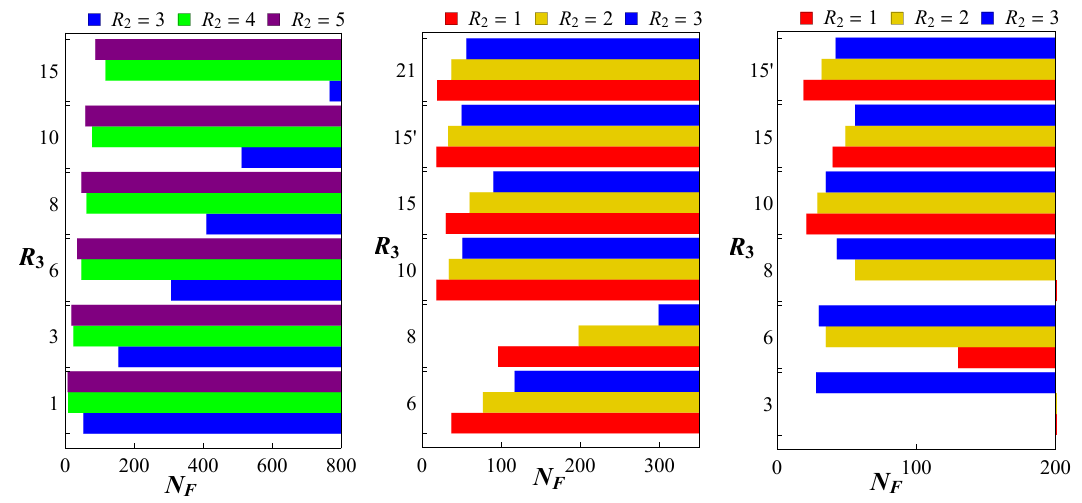
Figure 2 . Availability of weakly interacting UV (cid:12)xed points FP 2 (left panel), FP 3 (middle panel), and FP 4 (right panel) in dependence on the representation ( R 2 ; R 3 ) and the (cid:13)avor multiplicities N F of BSM fermions. The pattern of results continues to higher ( R 2 ; R 3 ). Partially interacting (cid:12)xed points FP 2 are absent for any N F as soon as R 2 = 1 or 2 ; FP 3 is absent whenever R 3 = 1 or 3 ; fully interacting UV (cid:12)xed points FP 4 are absent for R 3 = 1 or ( R 2 ; R 3 ) = ( 1 ; 8 ) ; ( 2 ; 3 ), and ( 1 ; 3